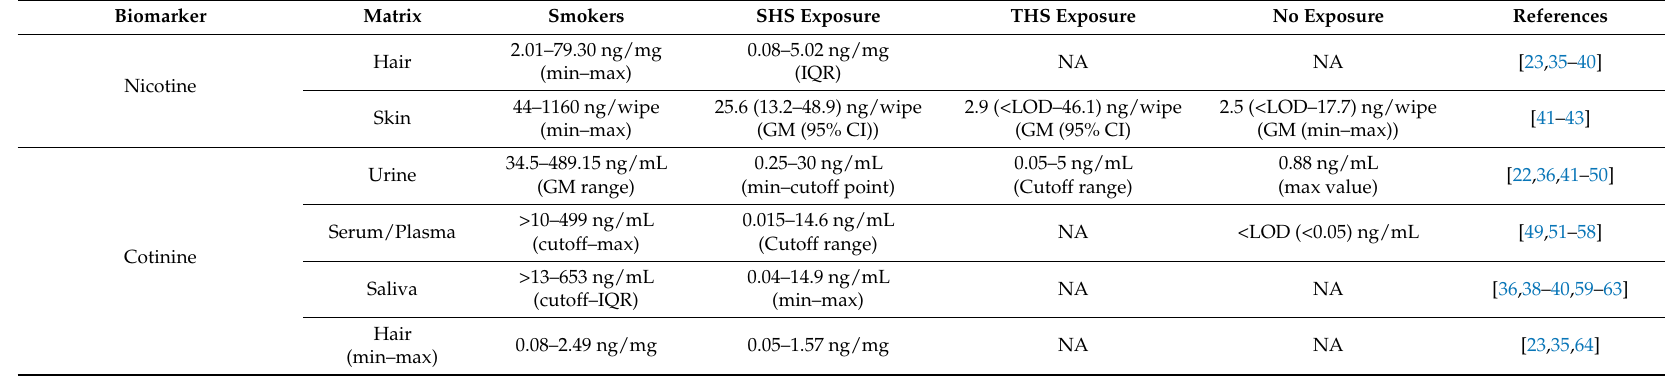
Table 2. Summary of the most common concentration ranges of the studied biomarkers in nonsmokers, accordingly with the reviewed references. Concentration ranges have been classified regarding the type of tobacco smoke exposure of the target population: “Smokers” for the smoker population and “SHS exposure”, “THS exposure” or “No exposure”, for non-exposed